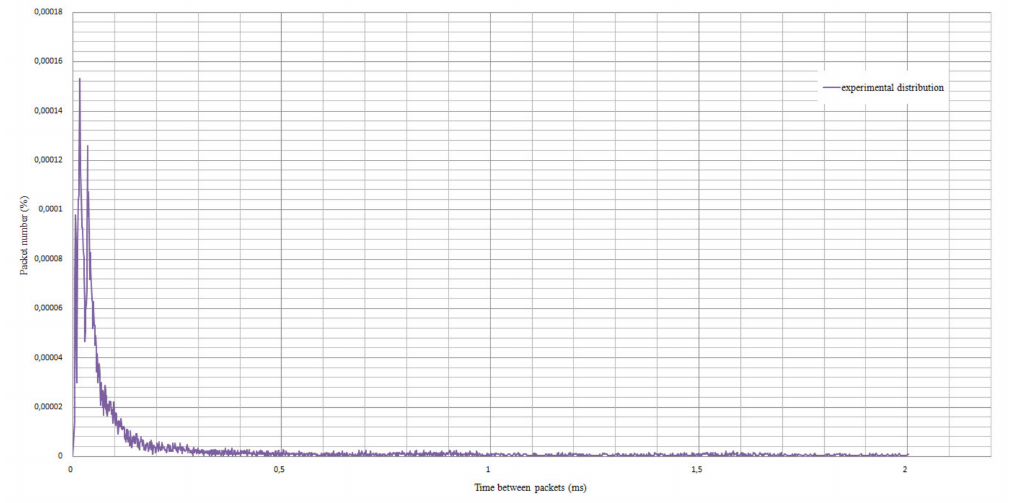
Figure 9. A diagram of the ratio of the packet number (%) to the time between packets